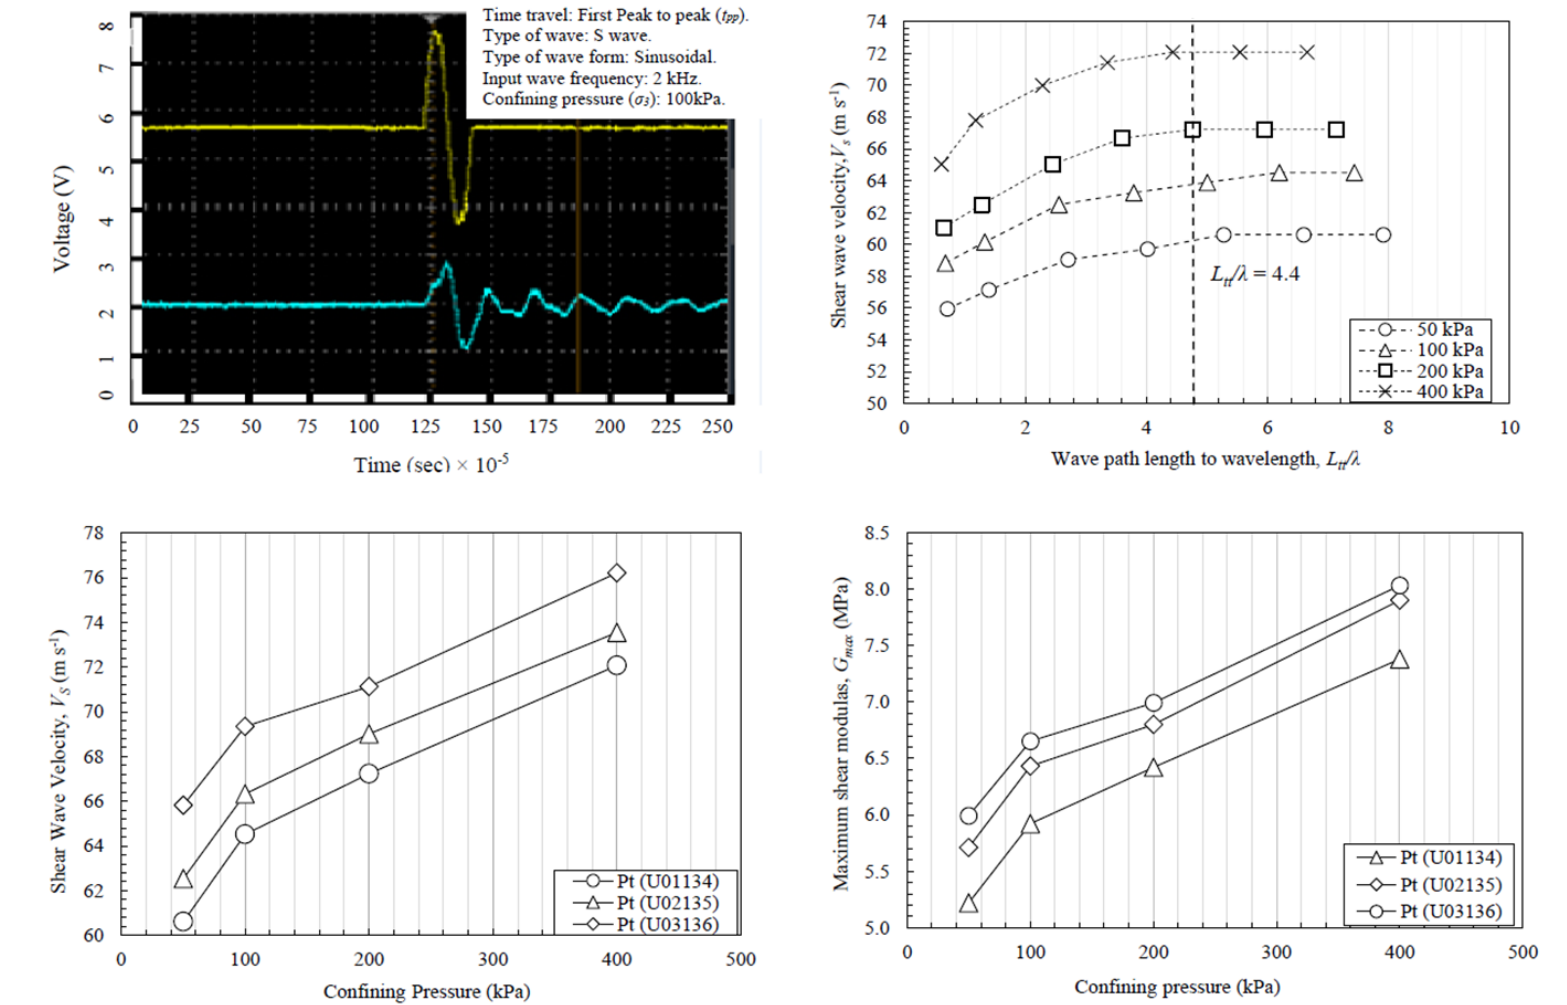
Figure A4. (a) Sample results of bender element test: (b) effect of L tt /λ ratio on shear wave velocity ( V s ) under confining pressure of 50, 100, 200 and 400 kPa, (c) comparison of shear wave velocity ( V s ) at different confining pressures for Agartala peat, (d) variation of small strain shear modulus ( G max ) with confining pressure for Agartala